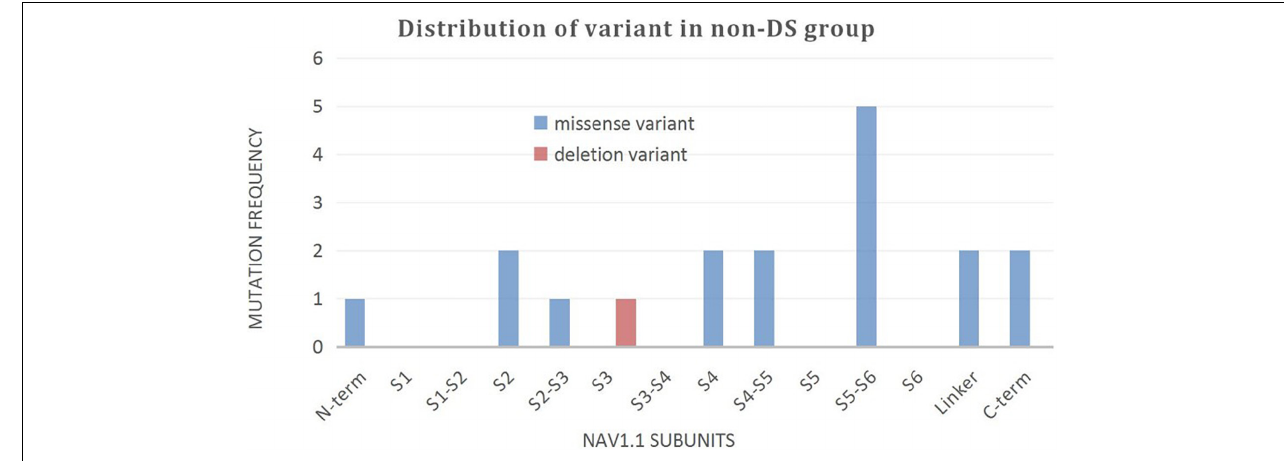
FIGURE 4 | Distribution of variant in non-DS